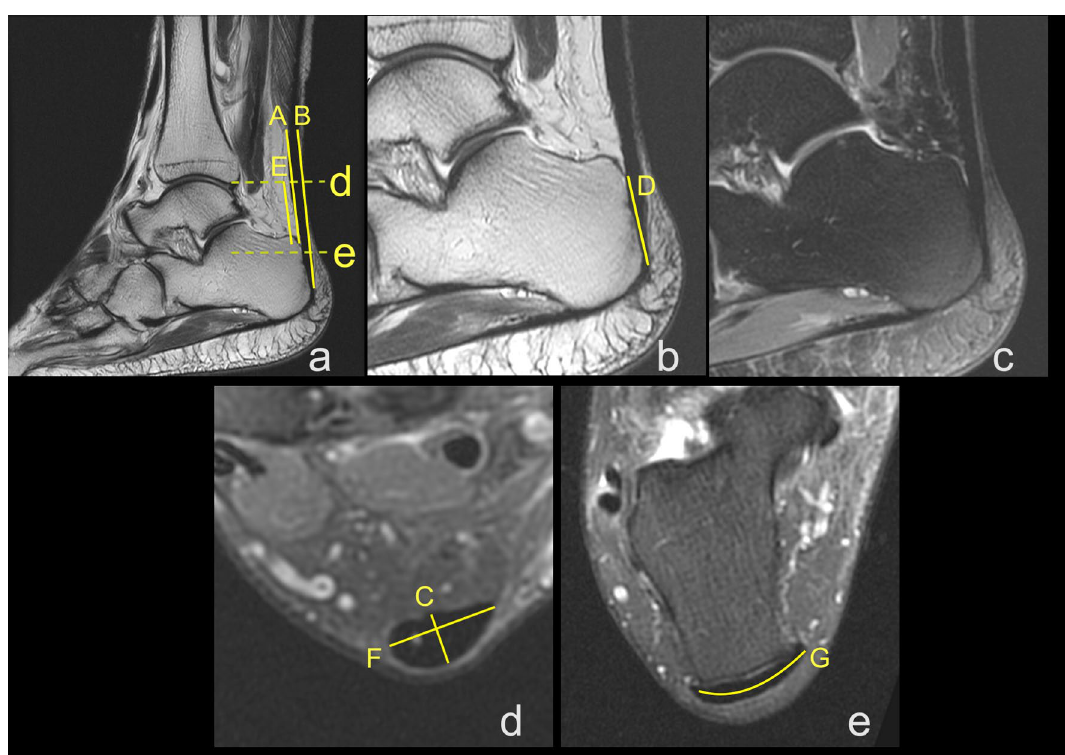
Figure 4. Insertion of the left Achilles tendon. A 61-year-old male who suffered from Achilles pain for eight months, with acute Achilles tendon pain one week before examination. Tendinopathy with partial rupture was suspected. A, B, C, D, F, G—dimensions of the Achilles tendon; definitions in the Material and Methods. ( a ) and ( b ) Sagittal T2-weighted FSE (fast spin echo), ( c )- sagittal PD-weighted FS (fat suppression), ( d ) and ( e ) axial PD-weighted